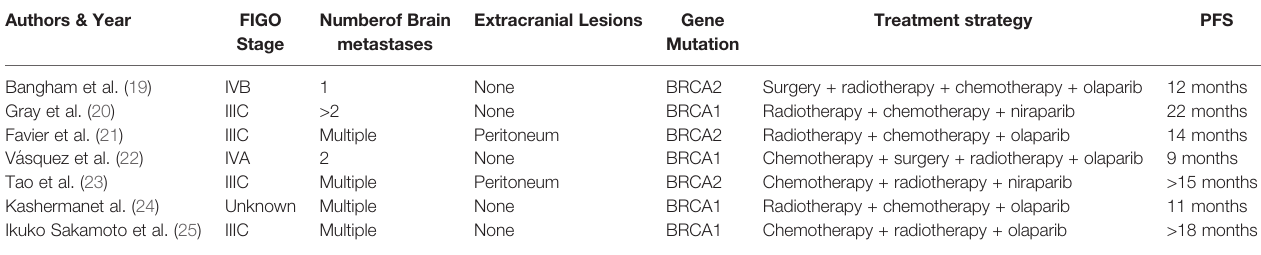
Extracranial Lesions Gene